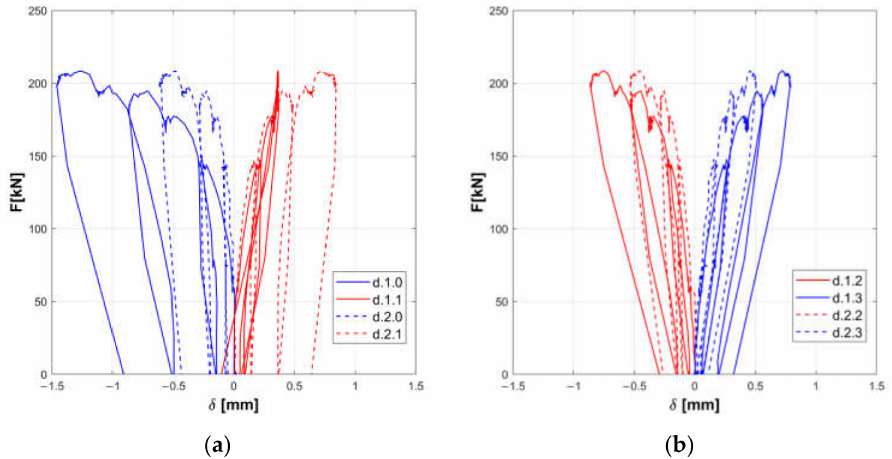
Figure 11. Experimental diagonal displacements of panel B: upper part ( a ) and lower part ( b ).